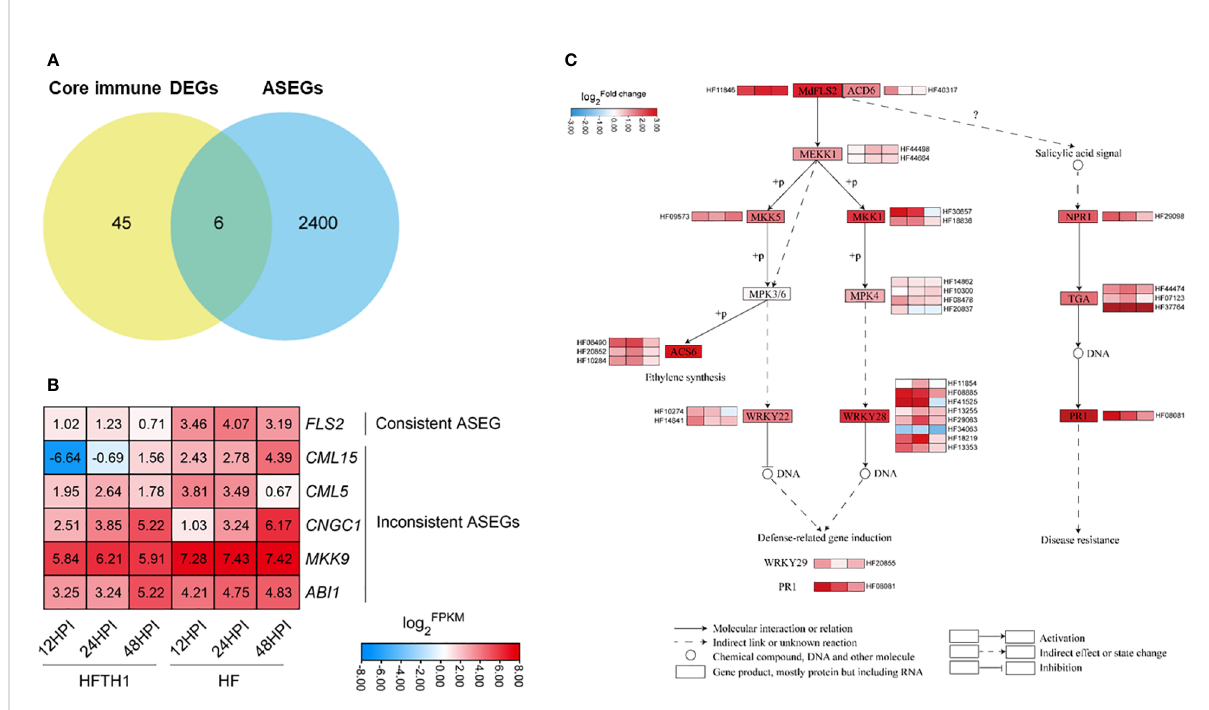
FIGURE 5 The ASE gene MdFLS2 may affect the defense response of apple leaves to AAAP. (A) Venn diagram analysis of “ core ” immune DEGs and ASEGs. (B) Heatmap showing log 2FPKM of six “ core ” immune ASEGs in HFTH1 and HF at 12, 24, and 48 h after AAAP inoculation. (C) Heatmap sequentially shows the log 2Fold change of genes from MdFLS2 -related pathway in HF compared with HFTH1 at 12, 24, and 48 h after AAAP